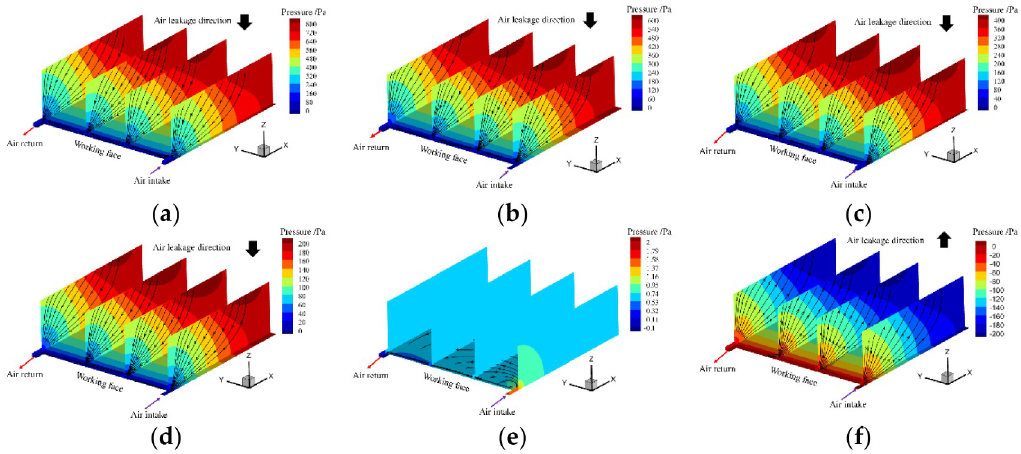
Fig 11. Distribution of pressure and air leakage flow field in goaf under different pressure differences between the ground surface and mining face. (a) Δ P = 800 Pa; (b) Δ P = 600 Pa; (c) Δ P = 400 Pa; (d) Δ P = 200Pa; (e) Δ P = 0 Pa; (f) Δ P = -200 Pa.